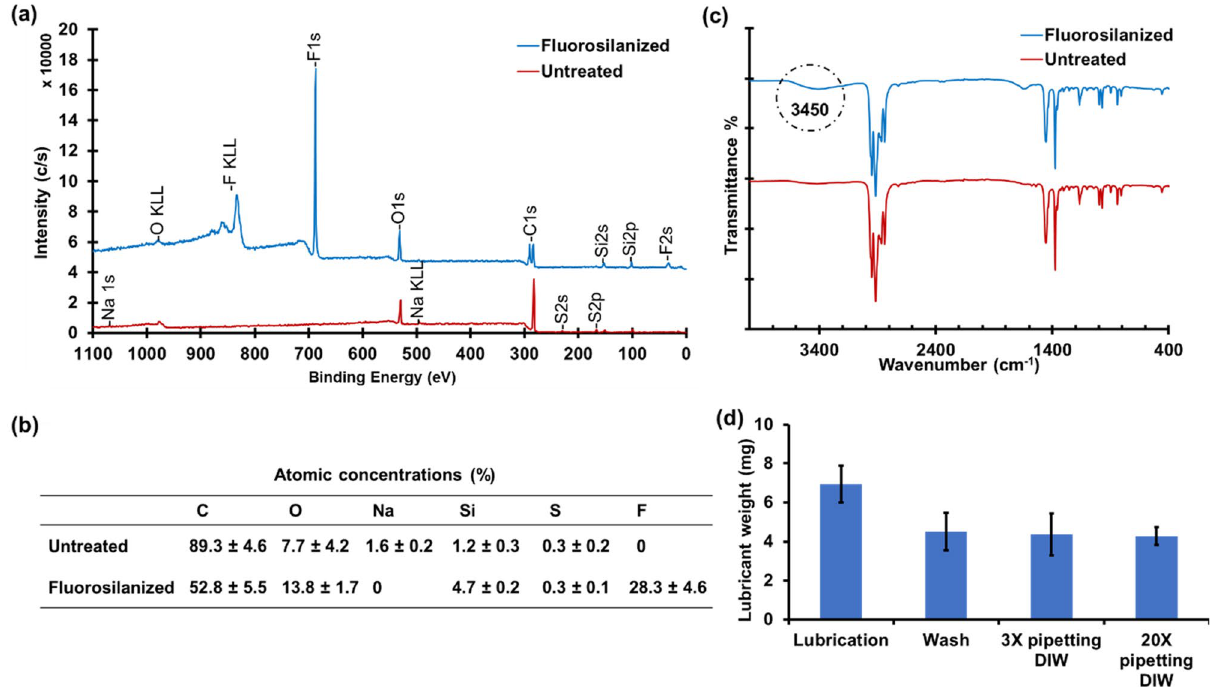
Figure 2. Characterization of the FS treated tips and lubricant stability . ( a ) XPS spectra of untreated tips and fluorosilanized tips. The emergence of F2 s , F1 s , and F KLL peaks are associated with the formation of FS layer inside the tips. ( b ) Atomic concentrations (%) of different elements at the inner surface of untreated and fluorosilanized tips resulted from high-resolution XPS analysis. ( c ) FTIR spectra of untreated pipette tips versus fluorosilanized tips. Circled broad peak in 3700–3200 cm −1 region indicates presence of Si–OH bonds . ( d ) Lubricant weight in the tips after lubrication, after washing off the excess amount of lubricant, and after pipetting DI water for 3 and 20 times. The amount of lubricant remained unchanged in the tips after multiple pipetting. The results are presented as means ±